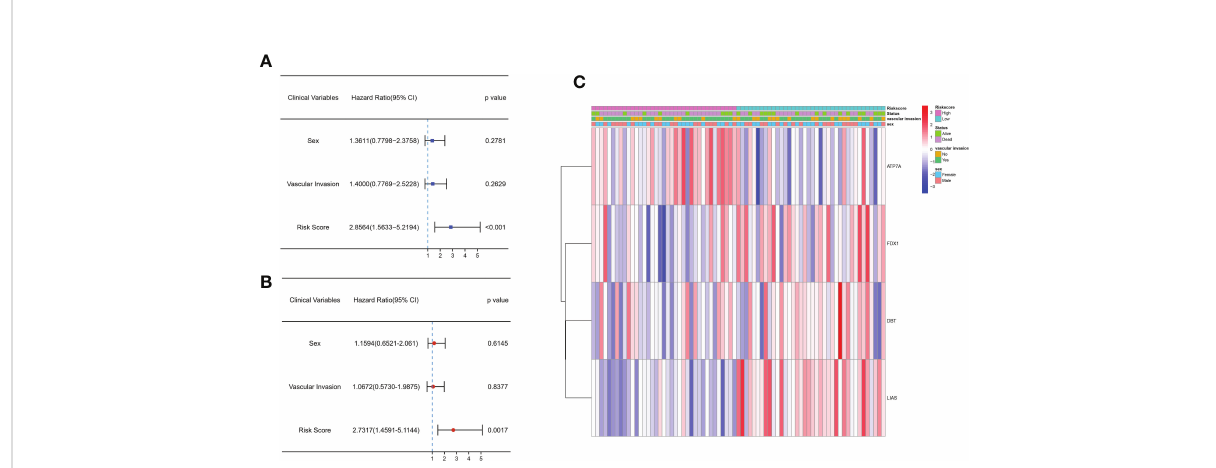
FIGURE 4 Univariate and multivariate Cox regression analyses of OS in the E-MTAB-6389 cohort. (A) Forest plot to demonstrate the univariate Cox regression analyses regarding OS in the E-MTAB-6389 cohort. (B) Forest plot showing the multivariate Cox regression analyses regarding OS in the E-MTAB-6389 cohort. (C) Heatmap demonstrating the correlation between 4 OS-related genes and clinical features (red: high expression; green: low expression).